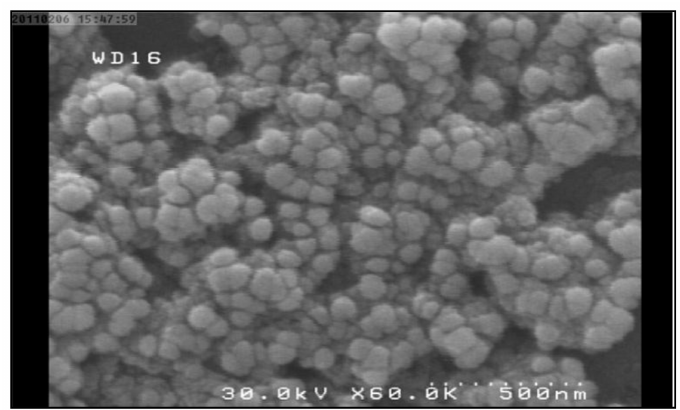
Figure 12. FESEM image of the dispersed TiO 2 nanofluid